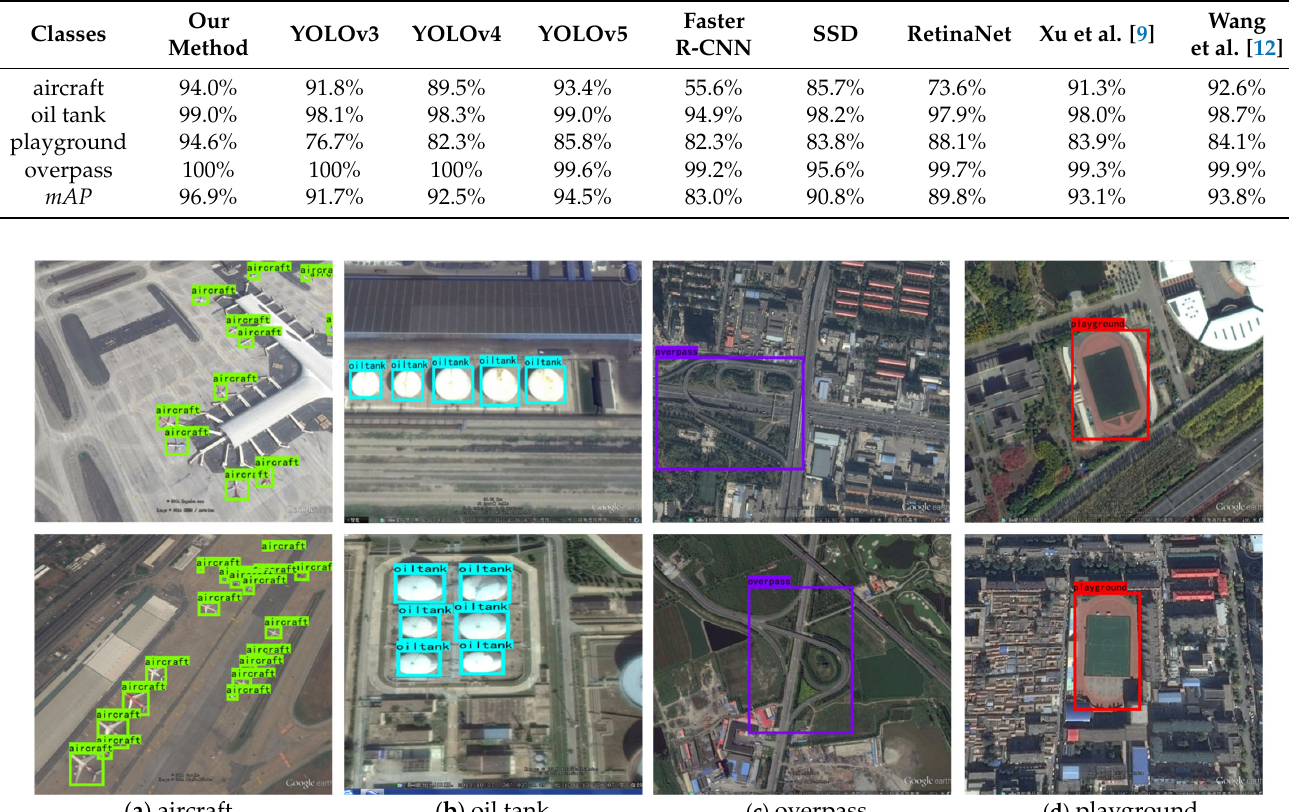
Table 2. The experimental results on the ROSD dataset.